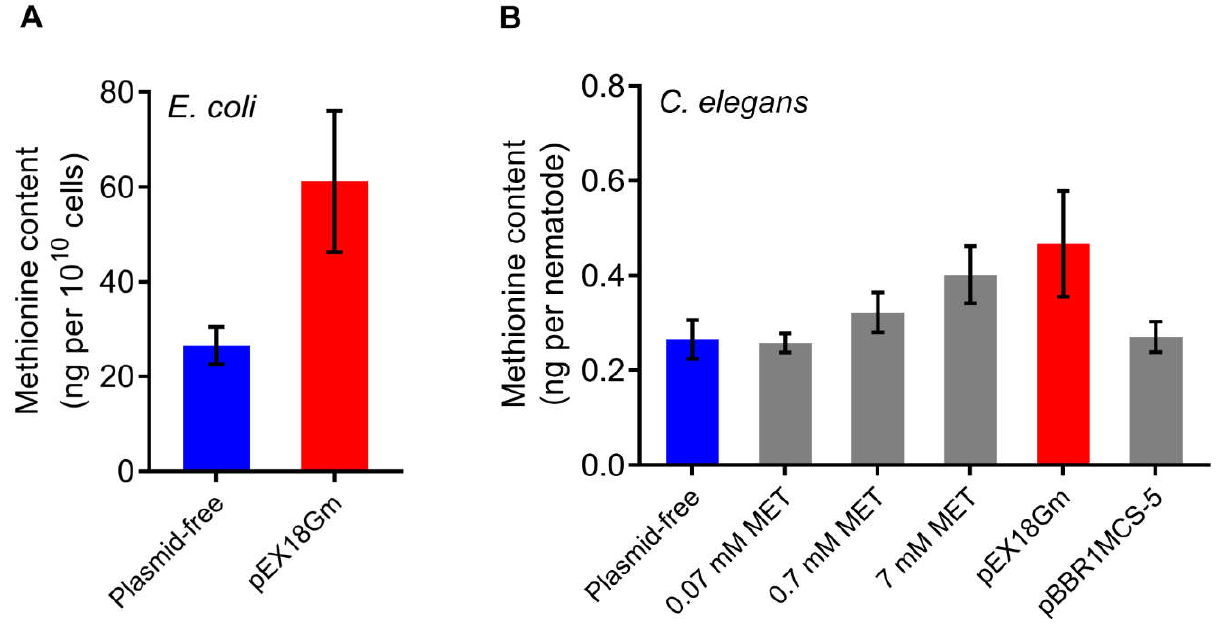
Figure 4. Methionine is a metabolite of pEX18Gm-induced increases in C. elegans fecundity. ( A ) Effect of the pEX18Gm plasmid on the methionine content in E. coli . ( B ) The methionine content of C. elegans in different diets. The treatment is the same as described in Figures 2B and 3B.